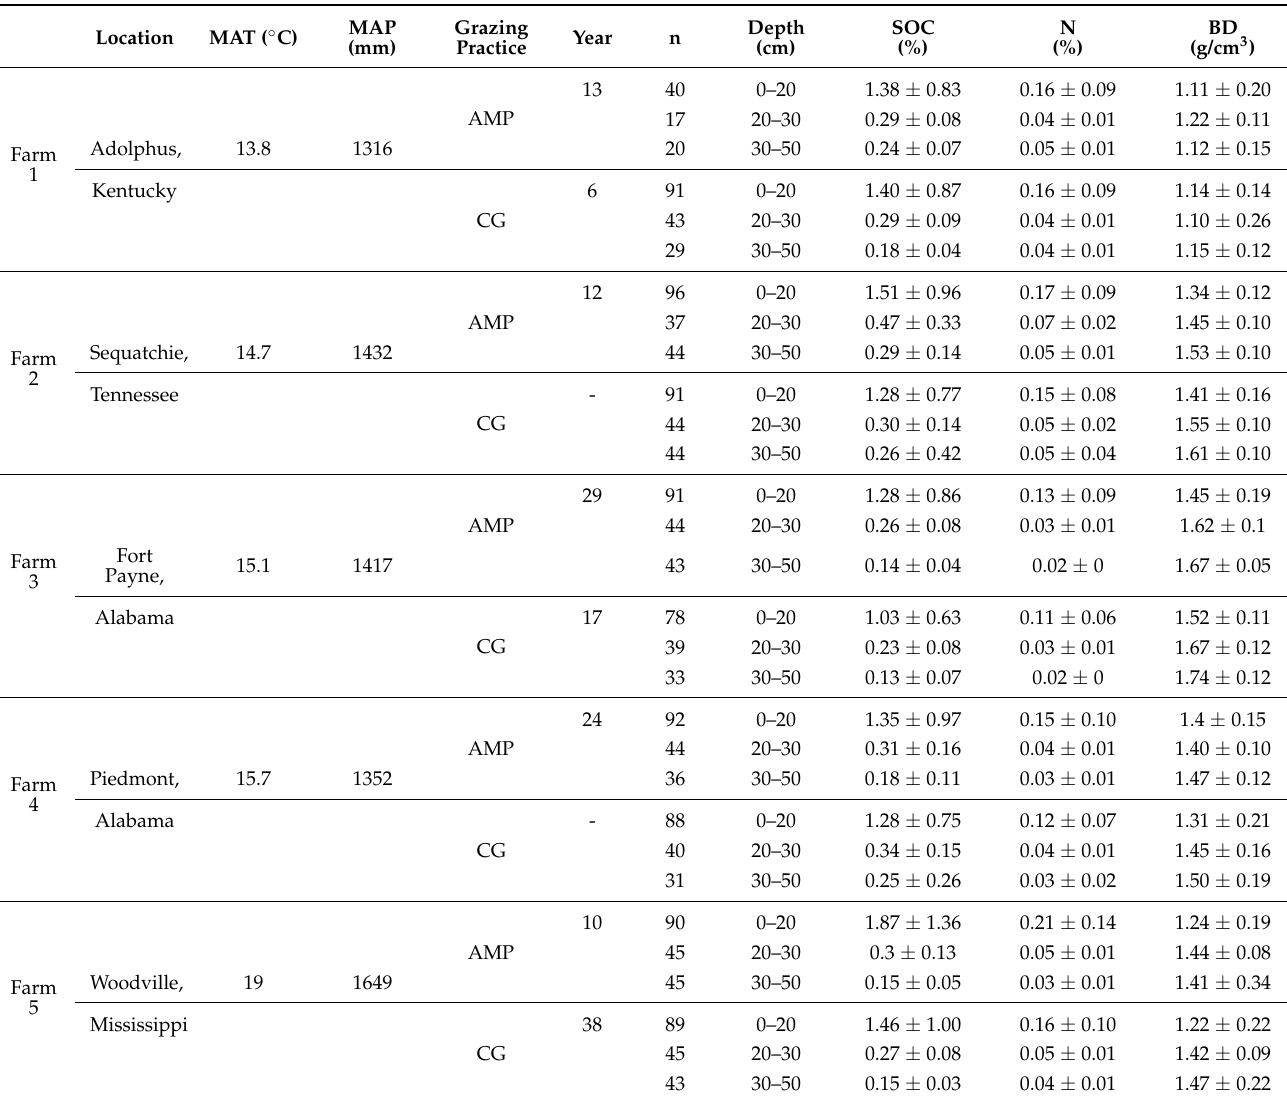
Table 1. Soil and climate characteristics in the neighboring adaptive multi-paddock (AMP) and conventional (CG) grazed pairs included in this study, data are from [11]. Mean and standard deviation of soil organic carbon (SOC), nitrogen (N), and bulk density (BD) are shown for each depth increment. Climate variables correspond to mean annual precipitation (MAP) and mean annual temperature